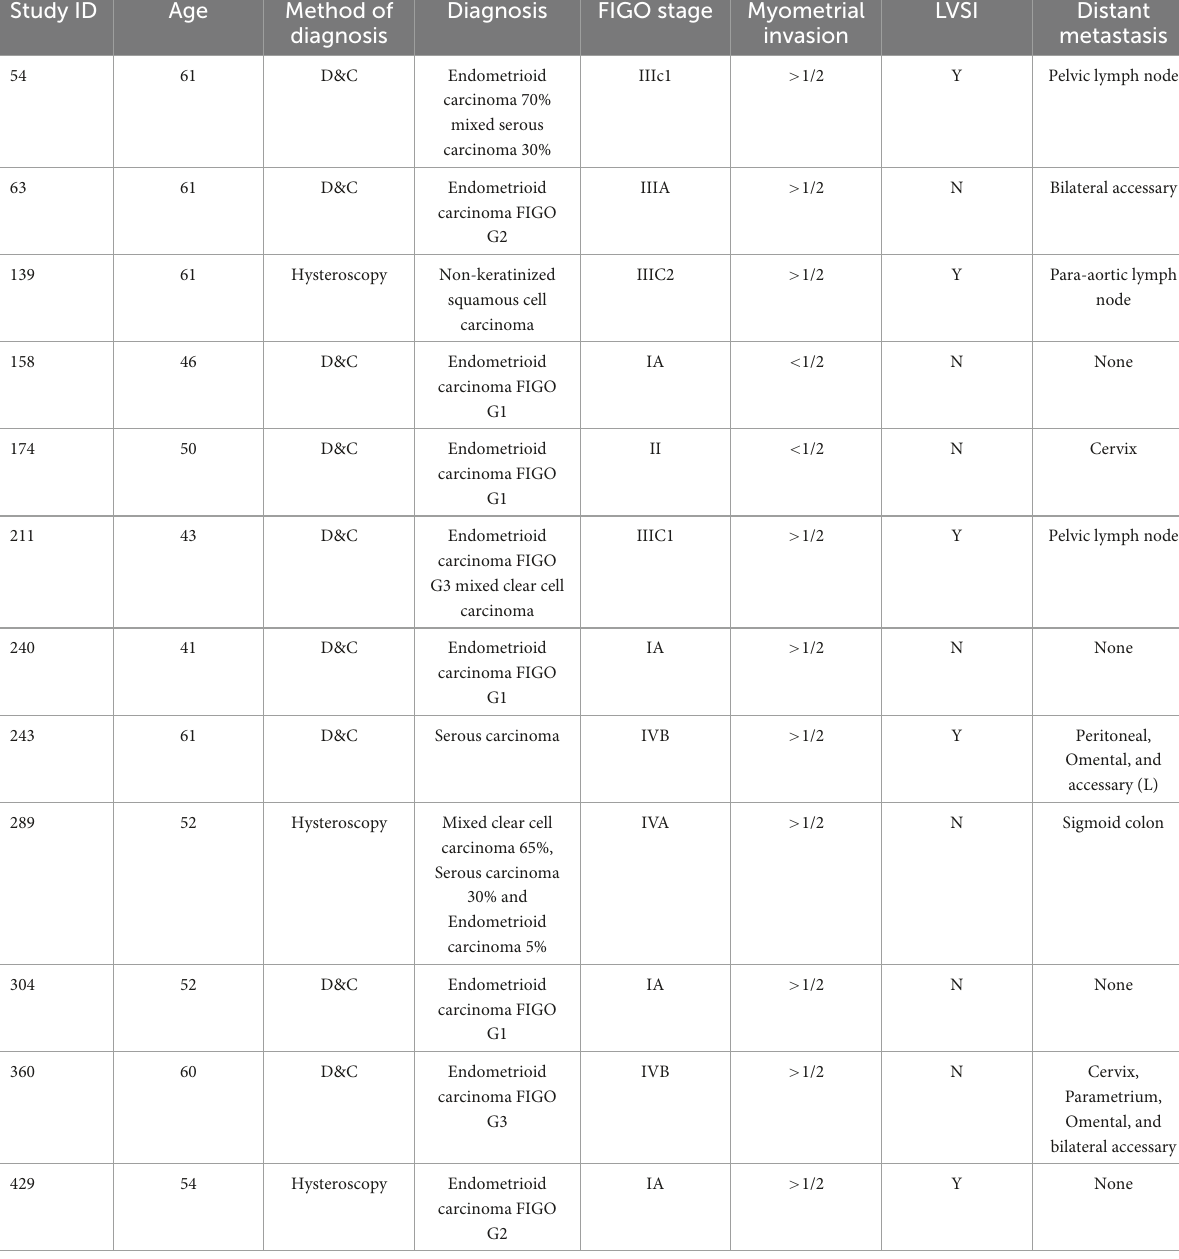
TABLE 3 Description of 12 patients with positive peritoneal cytology. Study